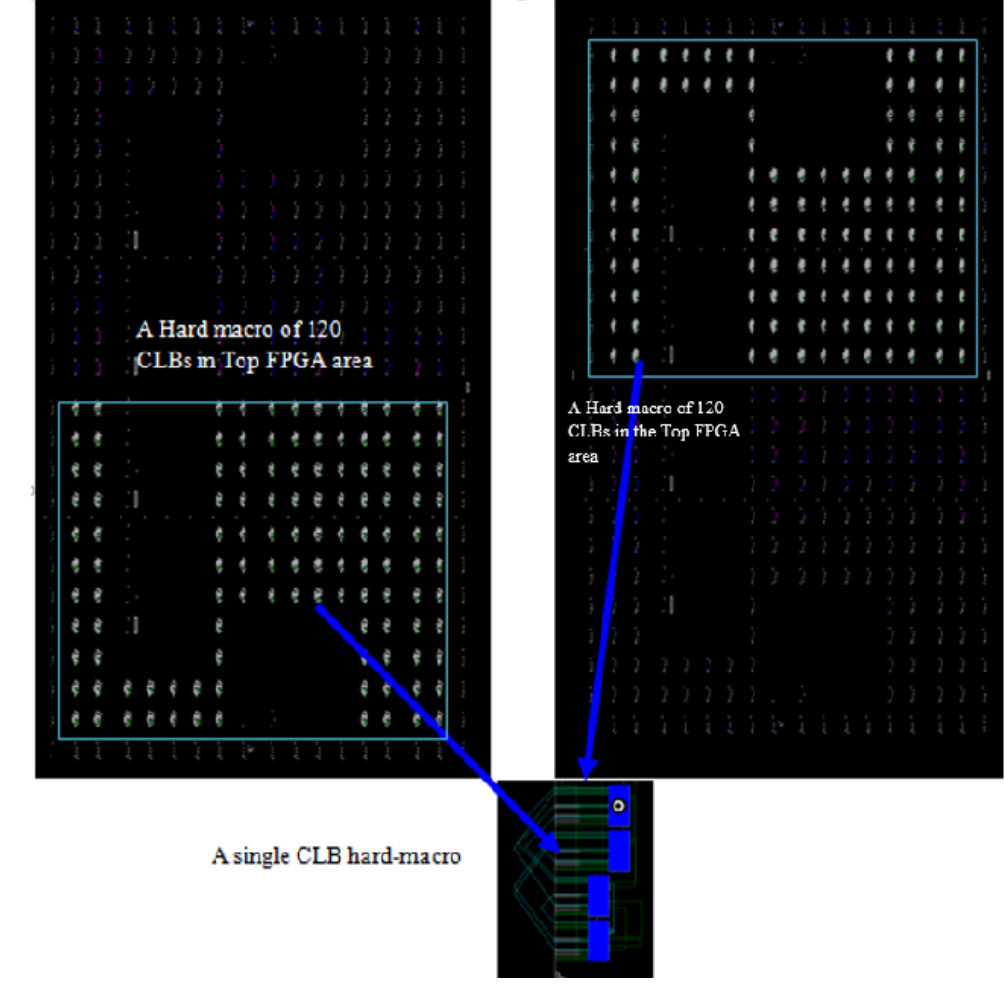
Figure 7. Implementation of the proposed d-ROPUF technique for an FPGA area (120